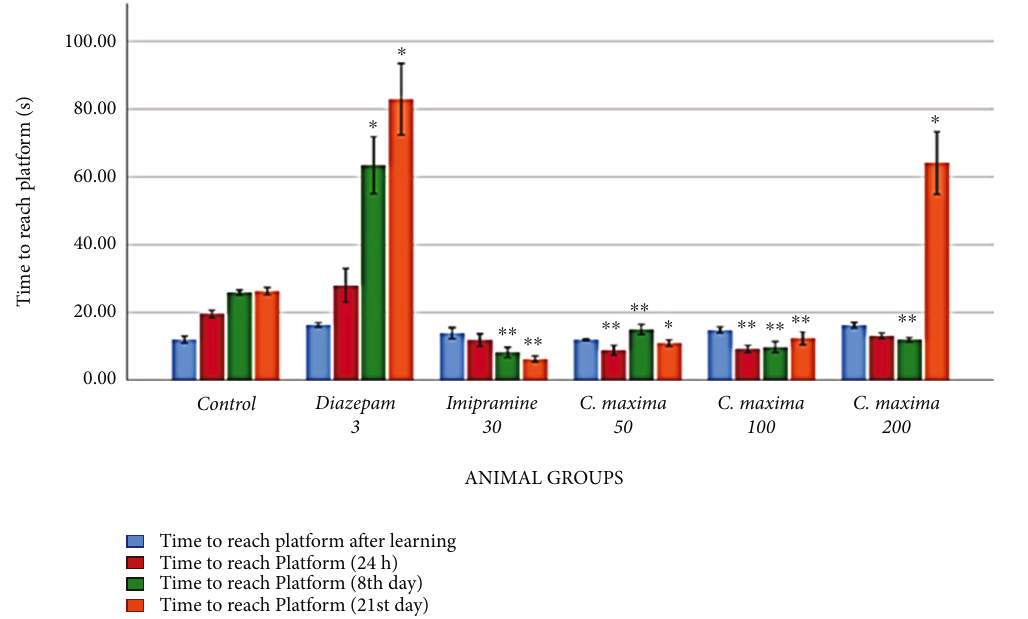
Figure 3: The outcome of C. maxima seeds on motor skilled learning and memory (stationary rod). Table 6: E ff ect of C. maxima seeds on anxiety by light and dark model.